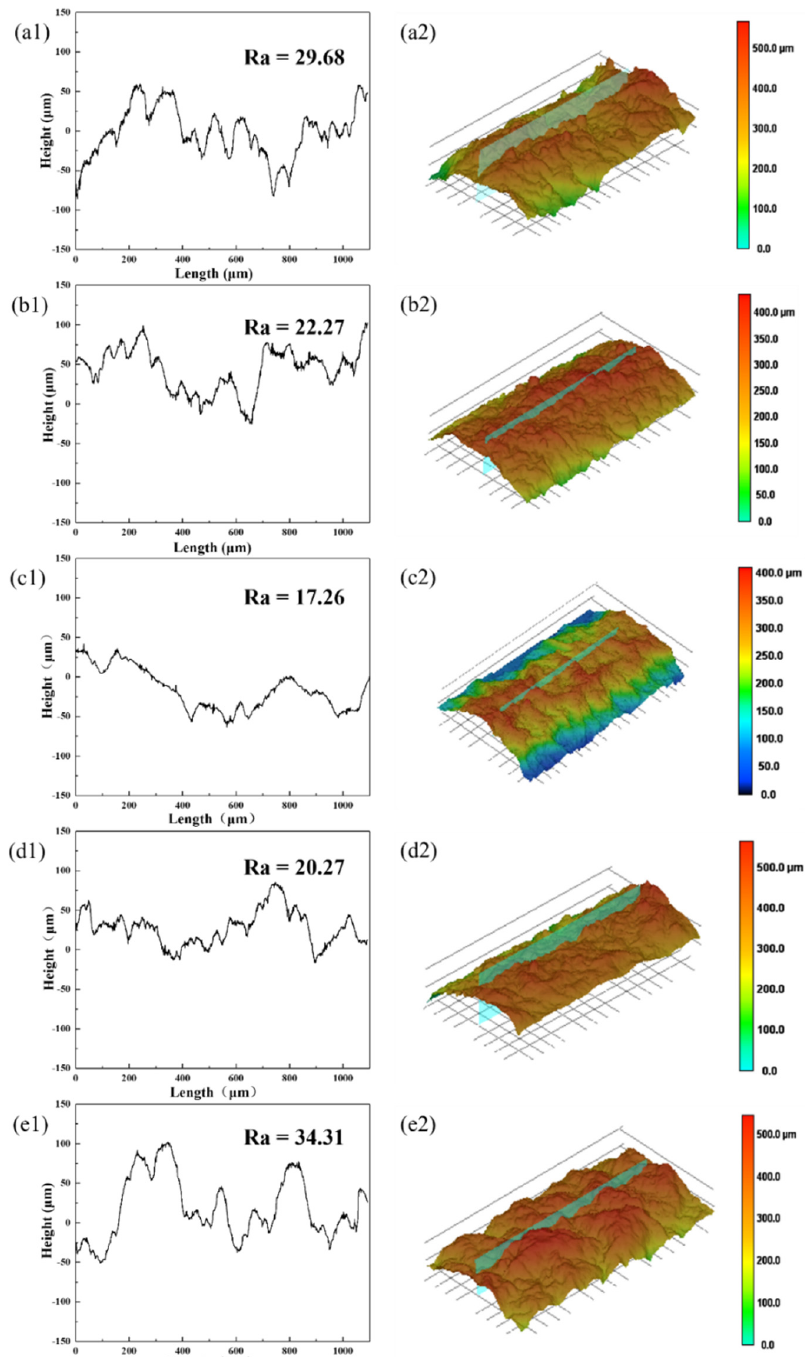
Figure 4. Two-dimensional morphology profile and three-dimensional morphology surface mor- phologies of RHEA specimens corresponding to the linear densities of ( a1,a2 ) E l = 2.8 J/mm, ( b1,b2 ) E l = 3.2 J/mm, ( c1,c2 ) E l = 3.6 J/mm, ( d1,d2 ) E l = 4.0 J/mm, ( e1,e2 ) E l = 4.4 J/mm.